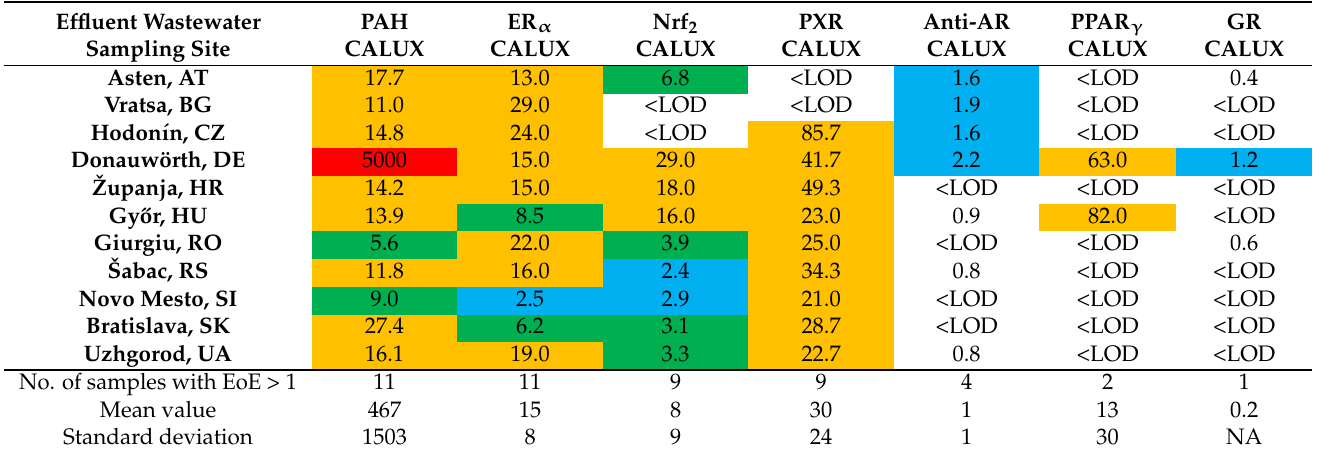
Table 4. Extent of exceedance (EoE) of EBT values and proposed action plan based on the signals of in vitro bioassays from analysis of JDS4 effluent wastewater